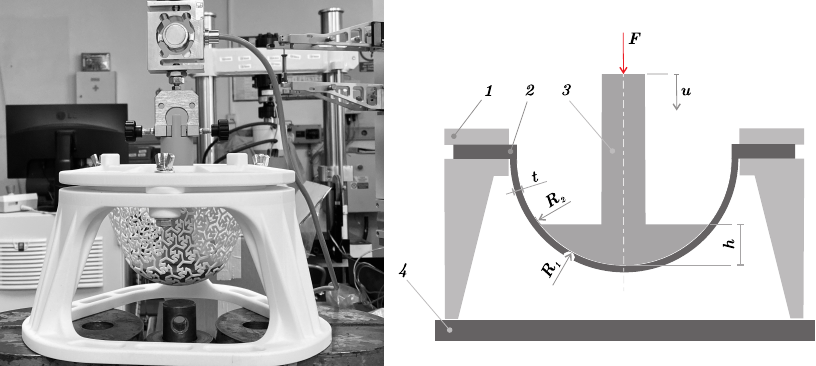
Figure 4. The experimental equipment ( left ) and its scheme ( right ): 1—fastening system, 2— specimen, 3—plunger,